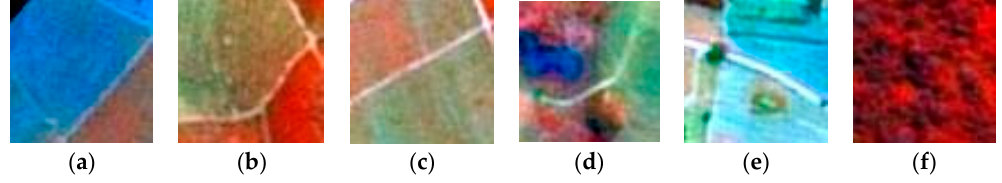
Figure 10. Example images of the Brazilian Coffee Scenes dataset in false colors: ( a – c ) coffee class; and ( d – f ) non-coffee class.